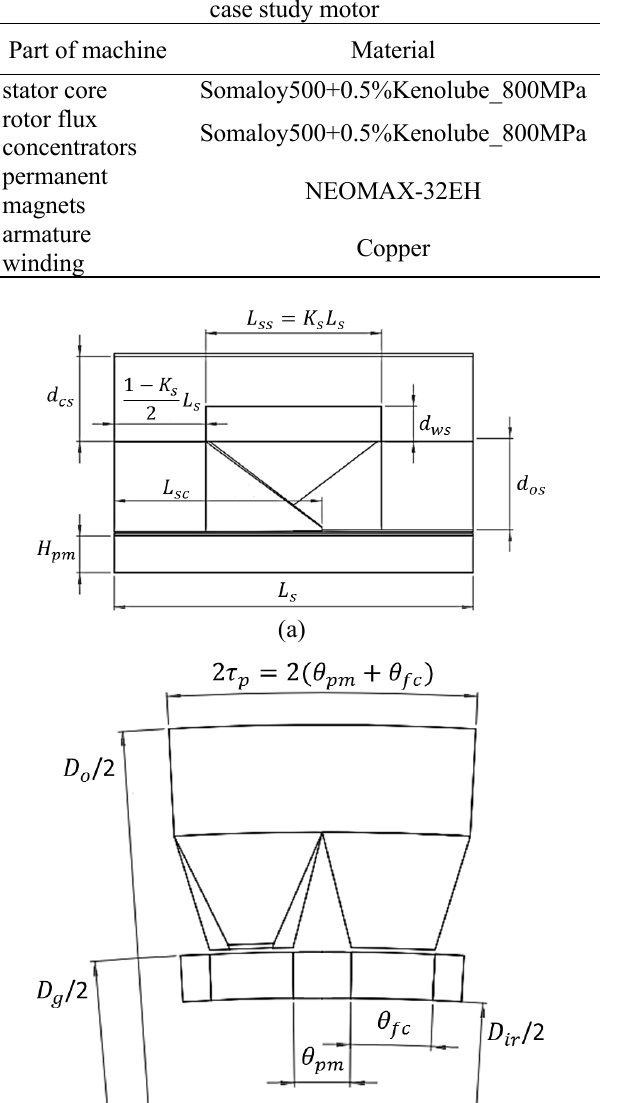
Table 4: Materials employed in the structure of